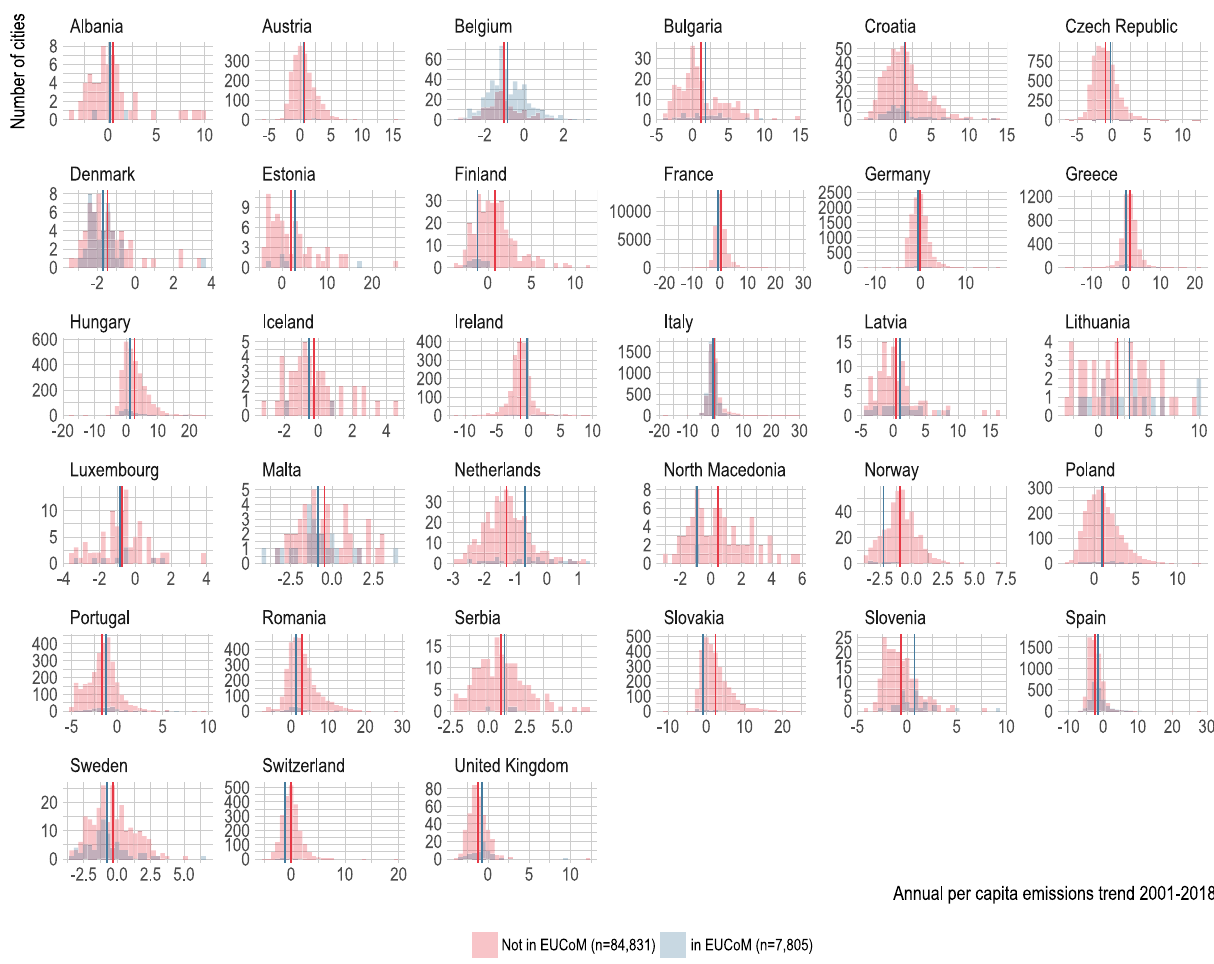
Fig. 6 | Comparing emission reductions betweencitygroups. Distributions of annualper capita emissions reductions between cities inthe EUCoM and external cities. Negative numbers indicate emissions reductions and mean annual per capita emissions trends for each group are designated with vertical lines in each